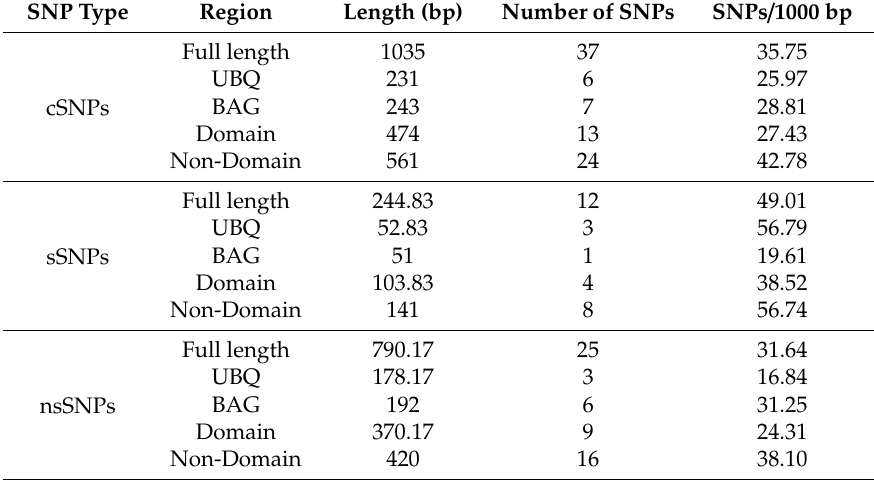
Table 3. Distribution of coding SNPs within BAG1 ’s UBQ-like and the BAG.